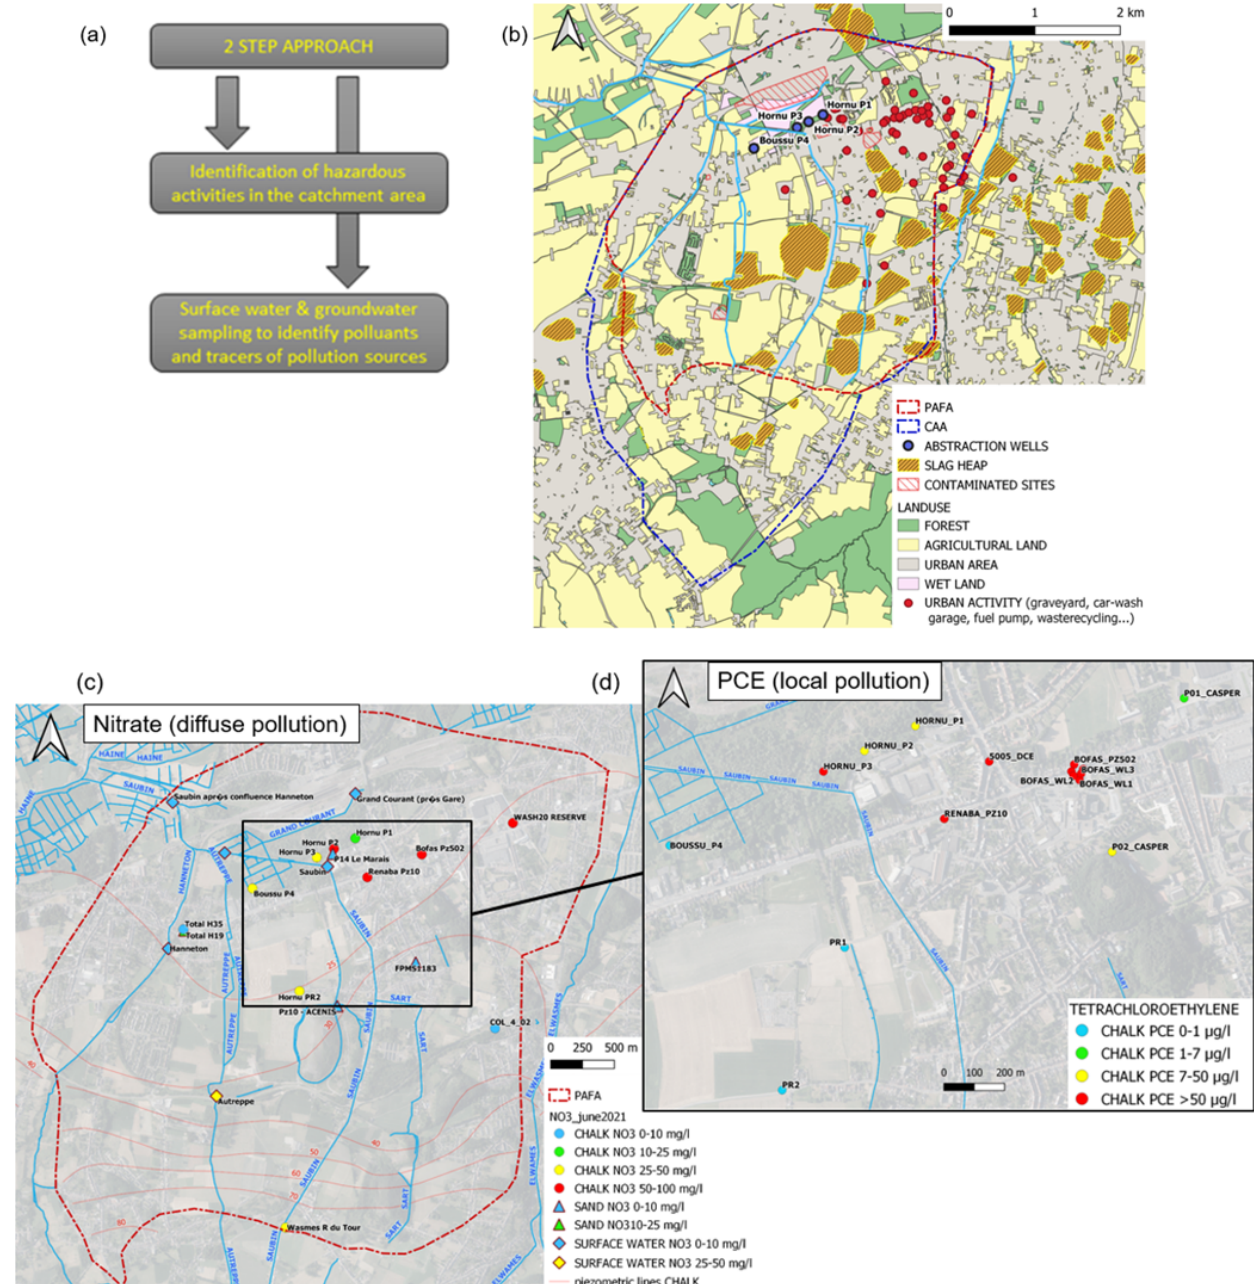
Figure 5. Procedure for identification of potential and existing sources of groundwater pollution: (a) the 2-steps approach schema, (b) car- tography of potential pollution sources, (c, d) spatial results of concentration of NO 3 and Chlorinated Solvants (Landuse and Satellite images on backgrounds are from ©